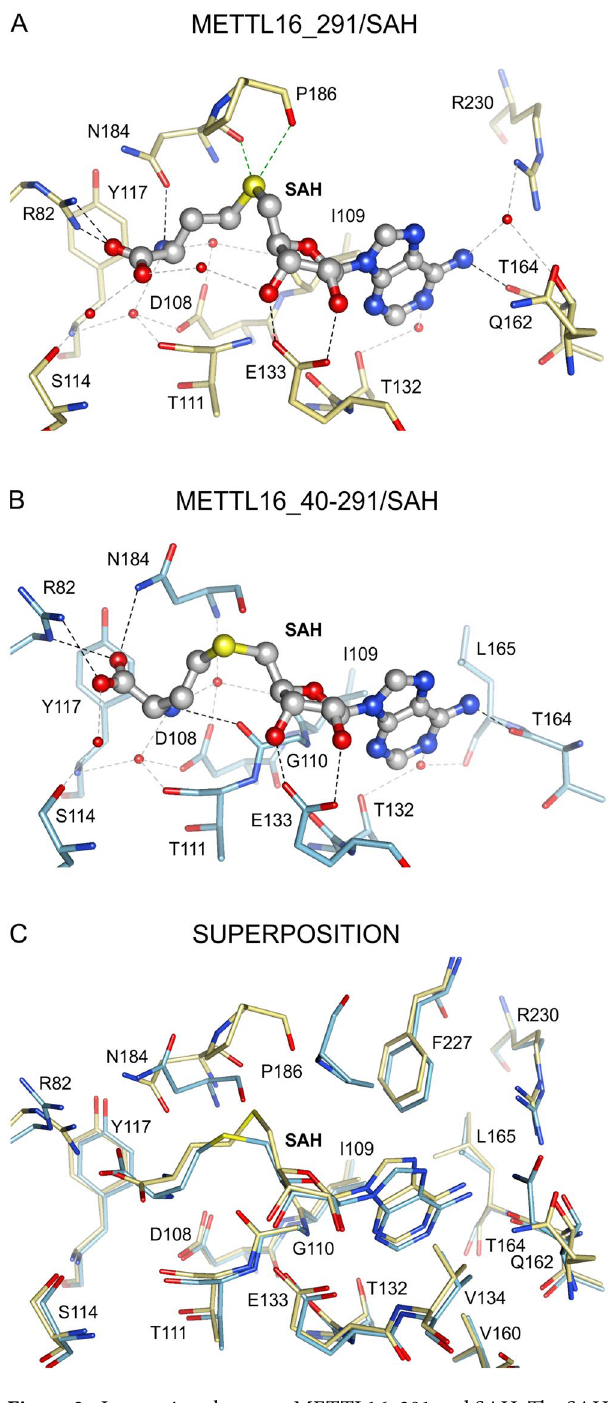
Figure 2. Interactions between METTL16_291 and SAH. The SAH-binding sites are shown for ( A ) METTL16_291/SAH complex (yellow sticks, PDB ID: 6b92), ( B ) METTL16_40–291/SAH (blue sticks, PDB ID: 2h00 27 ) and ( C ) superposition of METTL16_291/SAH and METTL16_40–291/SAH. Views of SAH-binding pocket are presented in the same orientation in all panels. Black, gray and green dashed lines respectively represent noncovalent interactions via hydrogen bonds, water-mediated hydrogen bonds and hypervalent sulfur-oxygen bonds 25 between SAH atoms and residues of METTL16. Water molecules are shown as red spheres. All residues forming the hydrophobic pocket (I109, V134, V160, L165 and F227) around the adenine moiety of SAH are shown together in panel